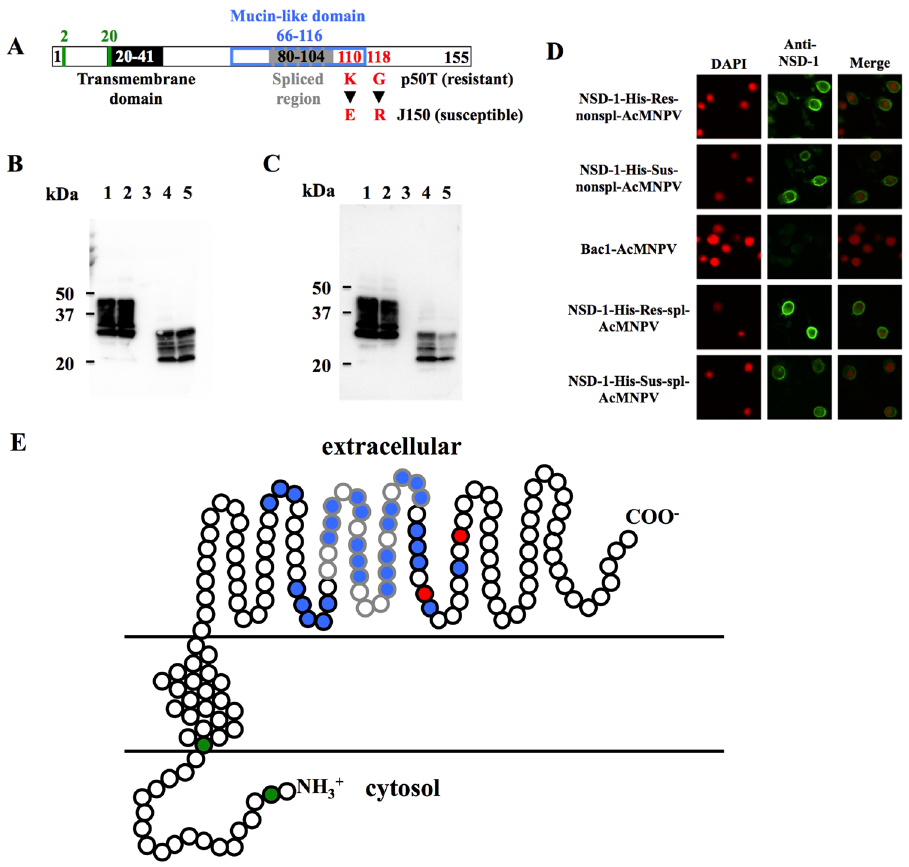
Figure 2. Characterization of the NSD-1 protein. ( A ) Predicted NSD-1 polypeptide. The figure indicates the nonspliced form of NSD-1. Black and gray boxes indicate the transmembrane domain and the region corresponding to the intron in the spliced form of nsd-1 , respectively. Green and blue boxes indicate the putative N -linked and O -linked glycosylation (mucin-like domain) sites, respectively. K (lysine) at 110 and G (glycine) at 118 indicate the amino acid residues derived from the resistant strain p50T, while E (glutamic acid) at 110 and R (arginine) at 118 are the amino acid residues derived from the susceptible strain J150. ( B and ( C ) Western blot of recombinant NSD-1 in Sf9 cells using anti-His antibody ( B ) and anti-NSD-1 antibody ( C ). The membrane fraction was extracted from Sf9 cells and analyzed by western blot. The primary antibodies were anti-His antibody (1:3000) and anti-NSD-1 antibody (1:10,000), respectively. Lane 1, NSD-1-His-Res-nonspl- AcMNPV; 2, NSD-1-His-Sus-nonspl-AcMNPV; 3, Bac1-AcMNPV (negative control); 4, NSD-1-His-Res- spl-AcMNPV; 5, NSD-1-His-Sus-spl-AcMNPV. ( D ) Immunostaining of Sf9 cells infected with recombinant baculoviruses. The Sf9 cells were incubated with anti-NSD-1 antibody (1:100) followed by a secondary antibody labeled with AlexaFluor488 (1:500) (green) and counterstained with DAPI (1:1000) (red). DAPI staining (left); NSD-1 signals (center); merge (right). ( E ) Hypothetical membrane orientation of NSD-1 predicted by SOSUI (http://harrier.nagahama-i-bio.ac.jp/sosui/). The spliced form of NSD-1 lacks the gray region. The red filled circles indicate the positions of amino acids that vary between the resistant (p50T) and susceptible (J150) strains. The green and blue filled circles indicate the putative N -linked and O -linked glycosylation sites,